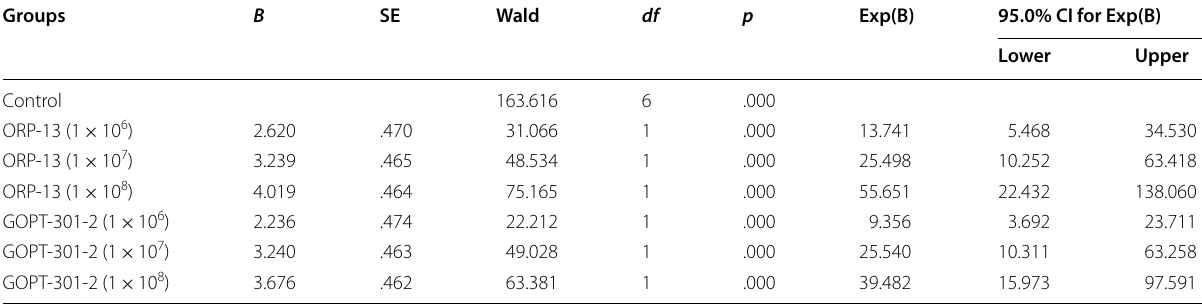
Table 5 Cox regression analysis results of Malacosoma neustria larvae exposed to different concentrations of ORP-13 and GOPT-301-2